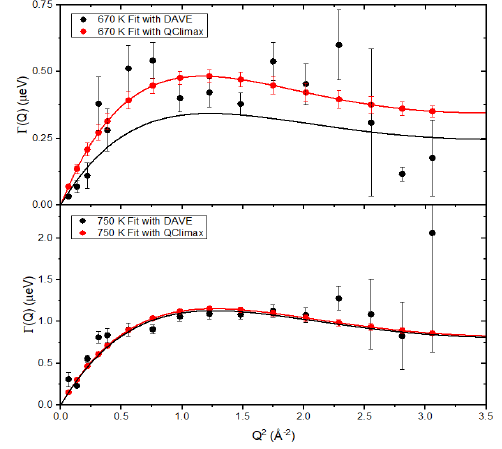
Figure 2. Example of fitting data using sequential and global fits in the case of BaH 2 [32], for T = 670K at the top and T = 750K at the bottom panel. The black points are the fitted values of Γ ( Q ) using sequential fitting (both DAVE and QClimax give the same values), the black trace is the fitting of the data to the Chudley–Elliott model, including all values. The red points are the fitted points using global fitting in QClimax, the red trace is the overall